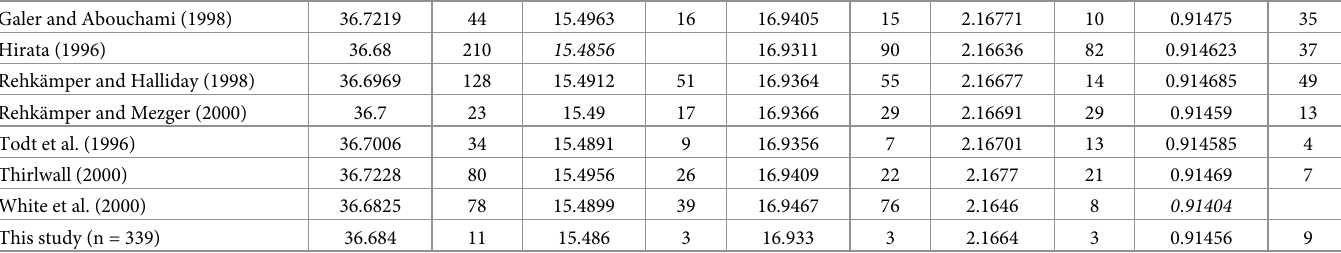
Analytical errors (2 sigma) refer to the least significant digits and results shown in italics were calculated from the data given in the original publication